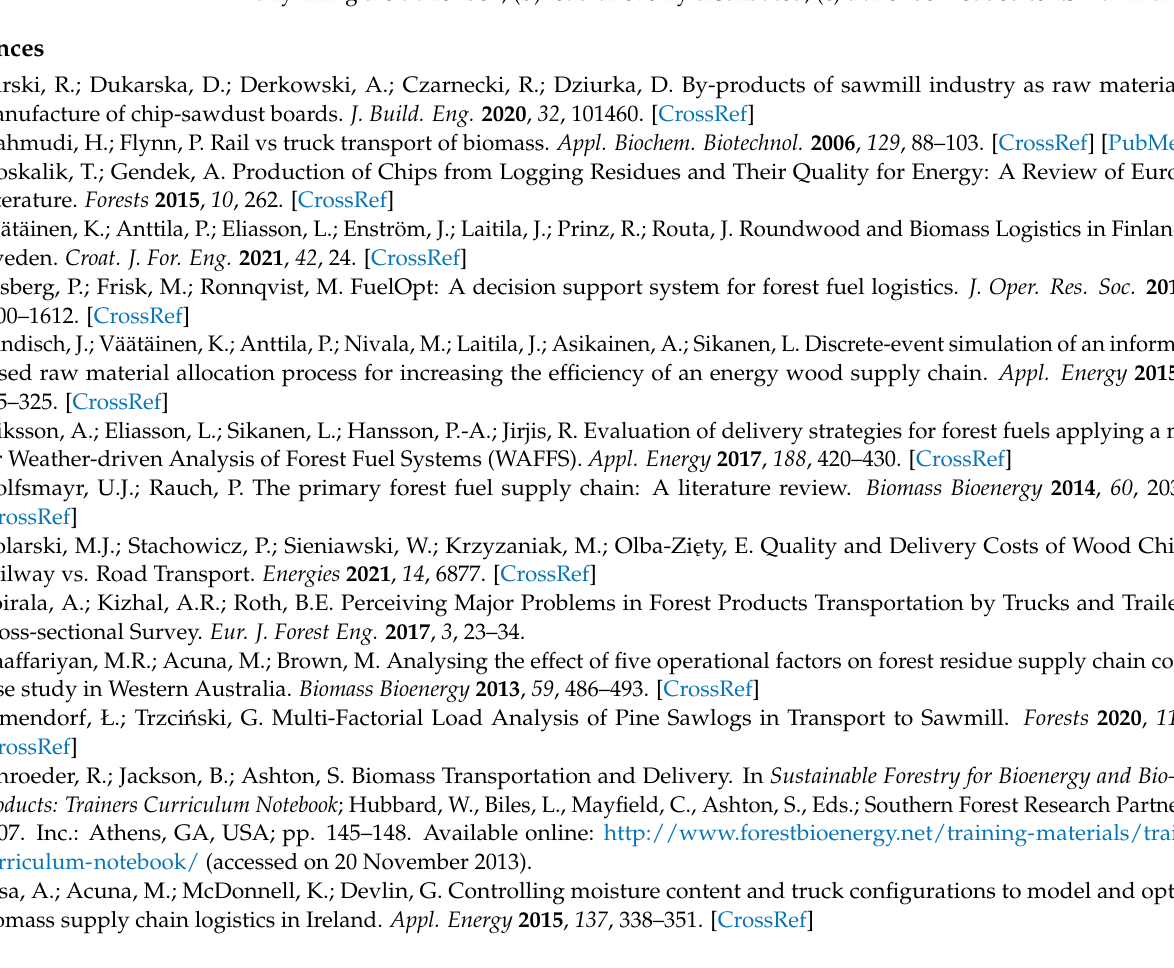
Figure A1. Different arrangement of the material on the trailer. ( a ) load evenly distributed but not fully filling the trailer box, ( b ) load unevenly distributed, ( c ) trailer box loaded to its maximum.